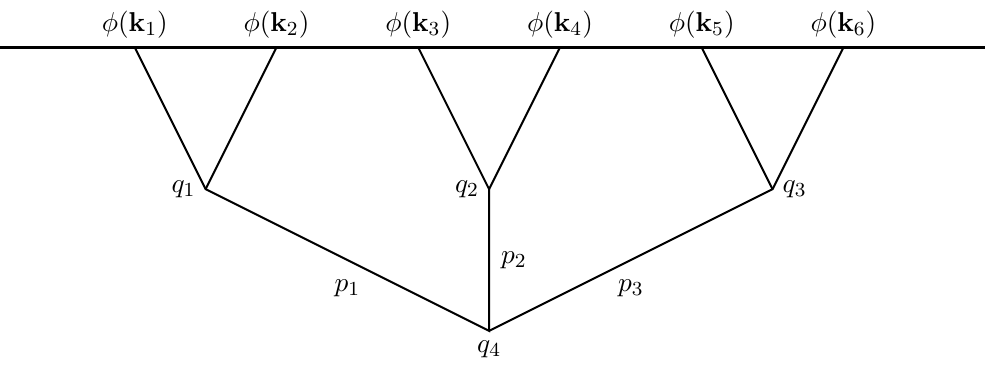
Figure 9 . The flux capacitor contribution to the 6-point function ψ 6 from the interaction φ 0 3 / 3! .